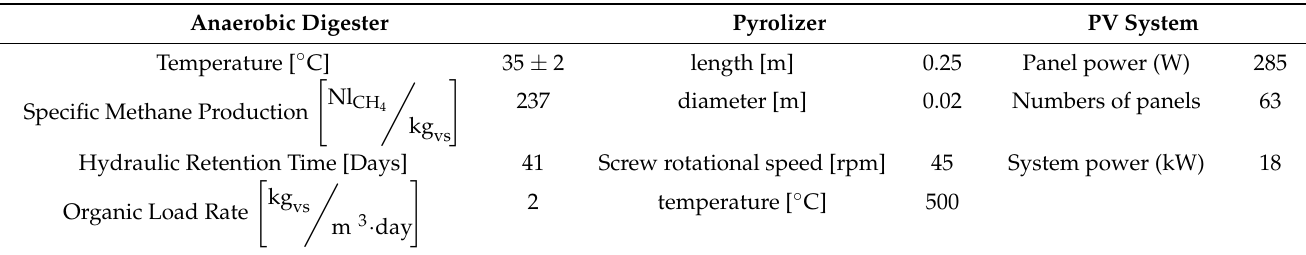
Table 1. Main design parameters of the plant. The geometrical and operating parameters of the pre-reformer and reformer are taken from the reference